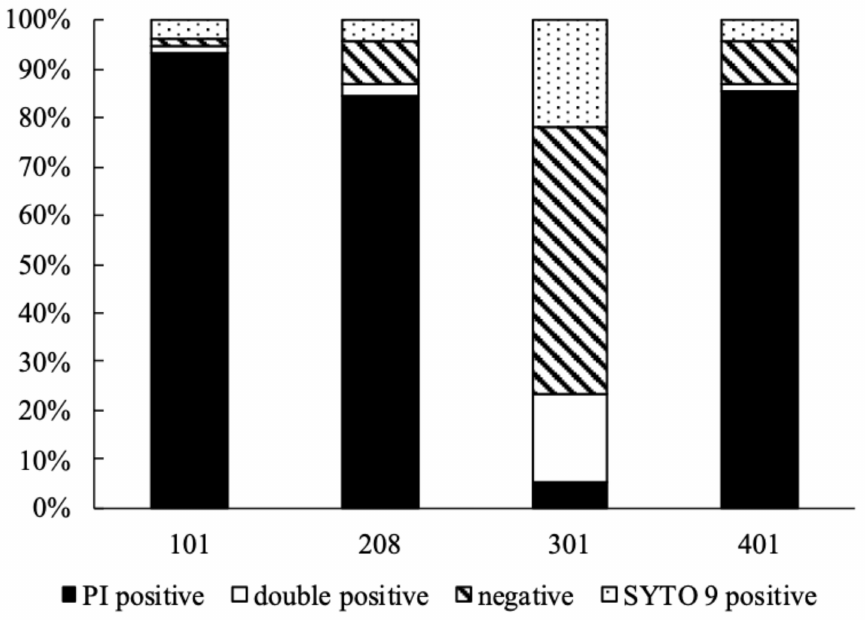
Figure 3. Survival diagram of Kocuria sp. 101, 208, 301, and 401 after 30-day desiccation.